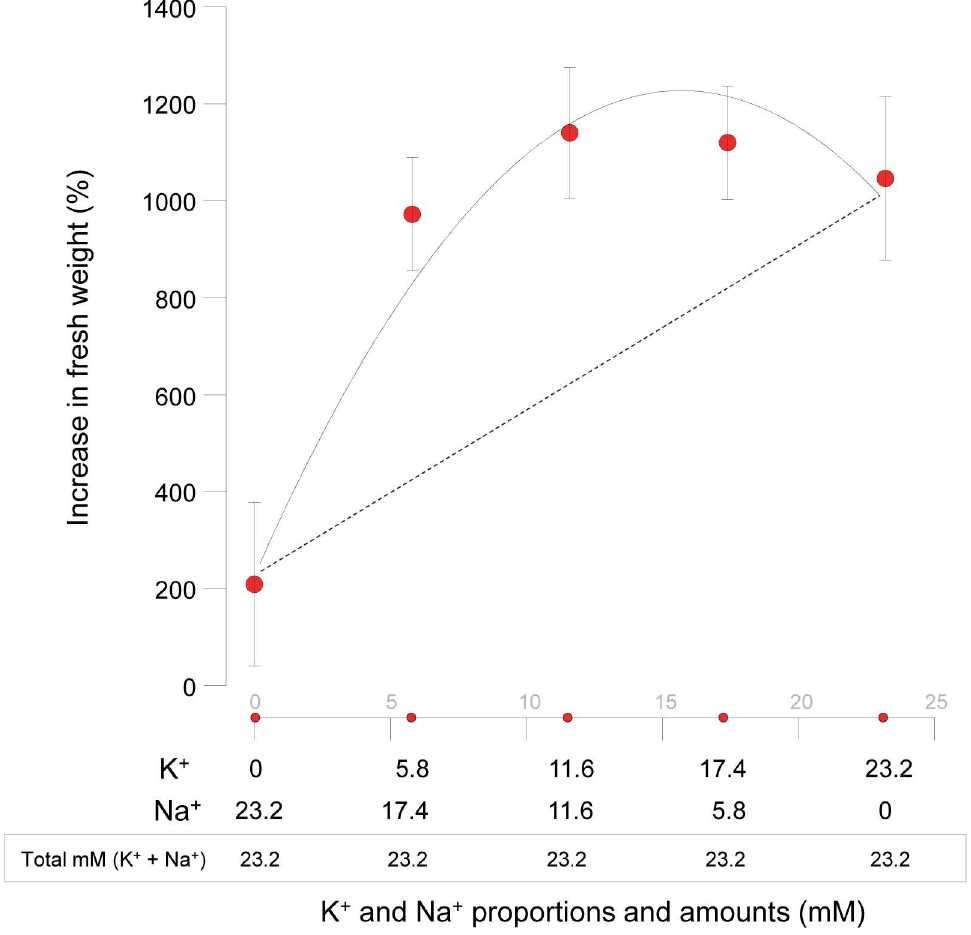
Fig 2. Response plot of the effect of the 2-component K + and Na + mixture on % increase in fresh weight of Valencia sweet orange nonembryogenic callus. The significant linear component, depicted by the dotted line, is the estimated response at each vertex (251% and 1011%), and the significant quadratic component indicates nonlinear blendingor that the response deviates (above) from what would be predicted by the linear component. However, the graphic reveals a sharp reduction in fresh weight at 0 mM K + / 23.2 mM Na + and essentially a flat relationshipbetween 5.9 mM K + / 17.3 mM Na + to 23 mM K + / 0.2 Na + . This indicatesa thresholdwhere Na + cannot completely substitute for K +